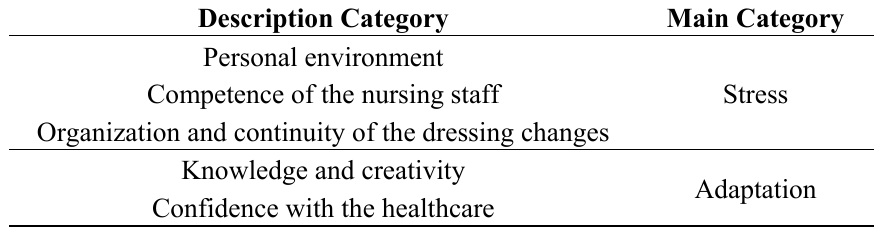
Table 2. Patients’ conceptions of being treated with NPWT: main categories and description